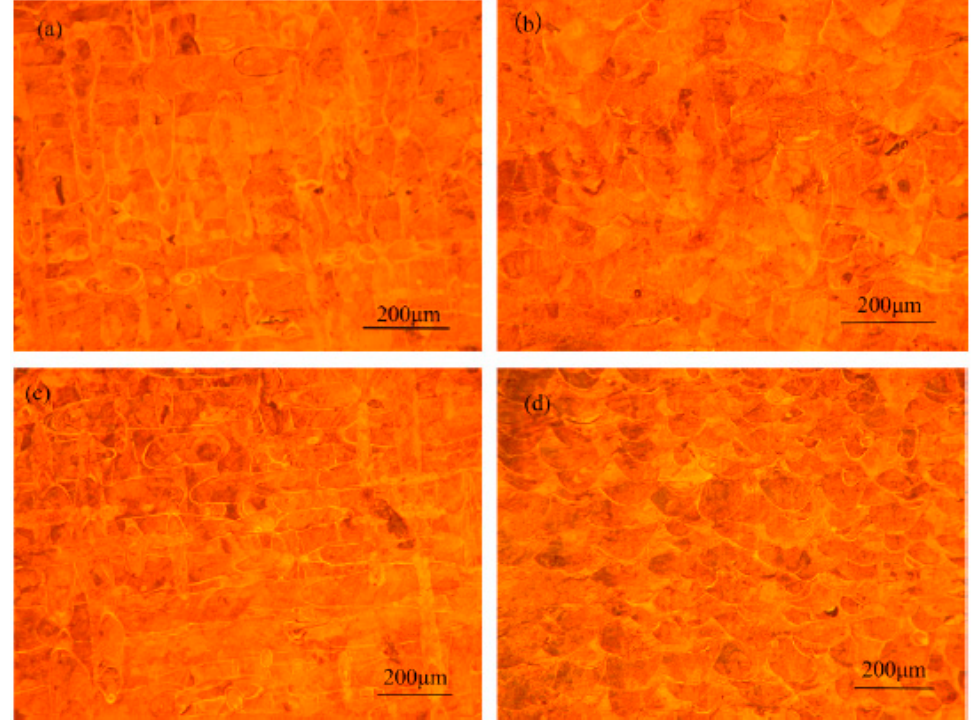
Figure 7. OM of L-PBF stainless steel 304 samples on cross-section and vertical section: ( a , b ) at an overlap rate of 0% showing full density, like ( c , d ) obtained with 50% overlap between parallel lines. From [105], with permission from Elsevier, 2019.